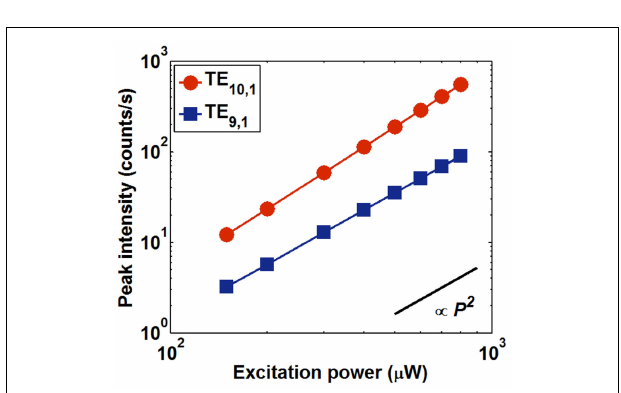
FIGURE 8 | Excitation power dependence of the emission intensities for resonant whispering gallery modes at 1704.4nm (TE 10,1 ) and 1809.9nm (TE 9,1 ), observed in the 3 µ m Ge disks